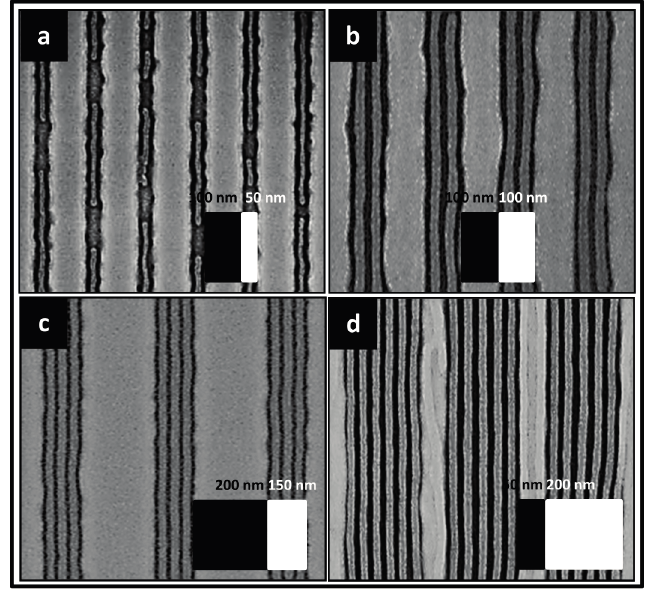
Figure 5. Top-down SEM images of the PS- b -PDMS pattern (as revealed by CF 4 and O 2 etches) formed on PDMS-OH brush modified patterned Si 3 N 4 substrates. Data shown are with Si 3 N 4 mesa and channel widths of ( a ) 100 nm and 50 nm; ( b ) 100 nm and 100 nm; ( c ) 200 nm and 150 nm; and ( d ) 50 nm and 200